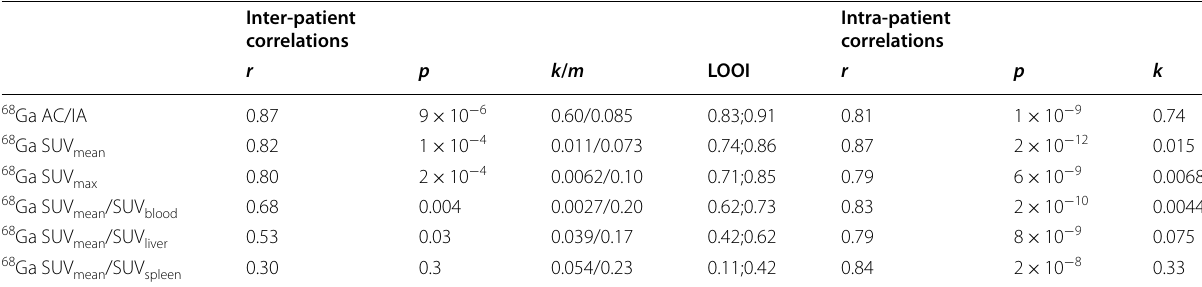
Table 3 Results for tumours of the 177 Lu-AC/IA with respect to various PET-derived explanatory variables